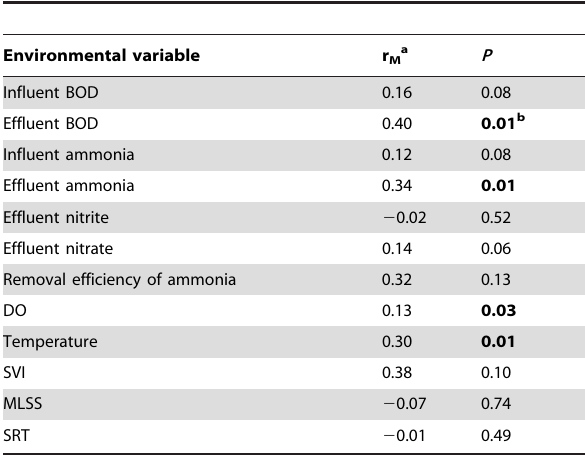
Table 1. Relationship of whole AOB community structure to individual environmental variables revealed by Mantel